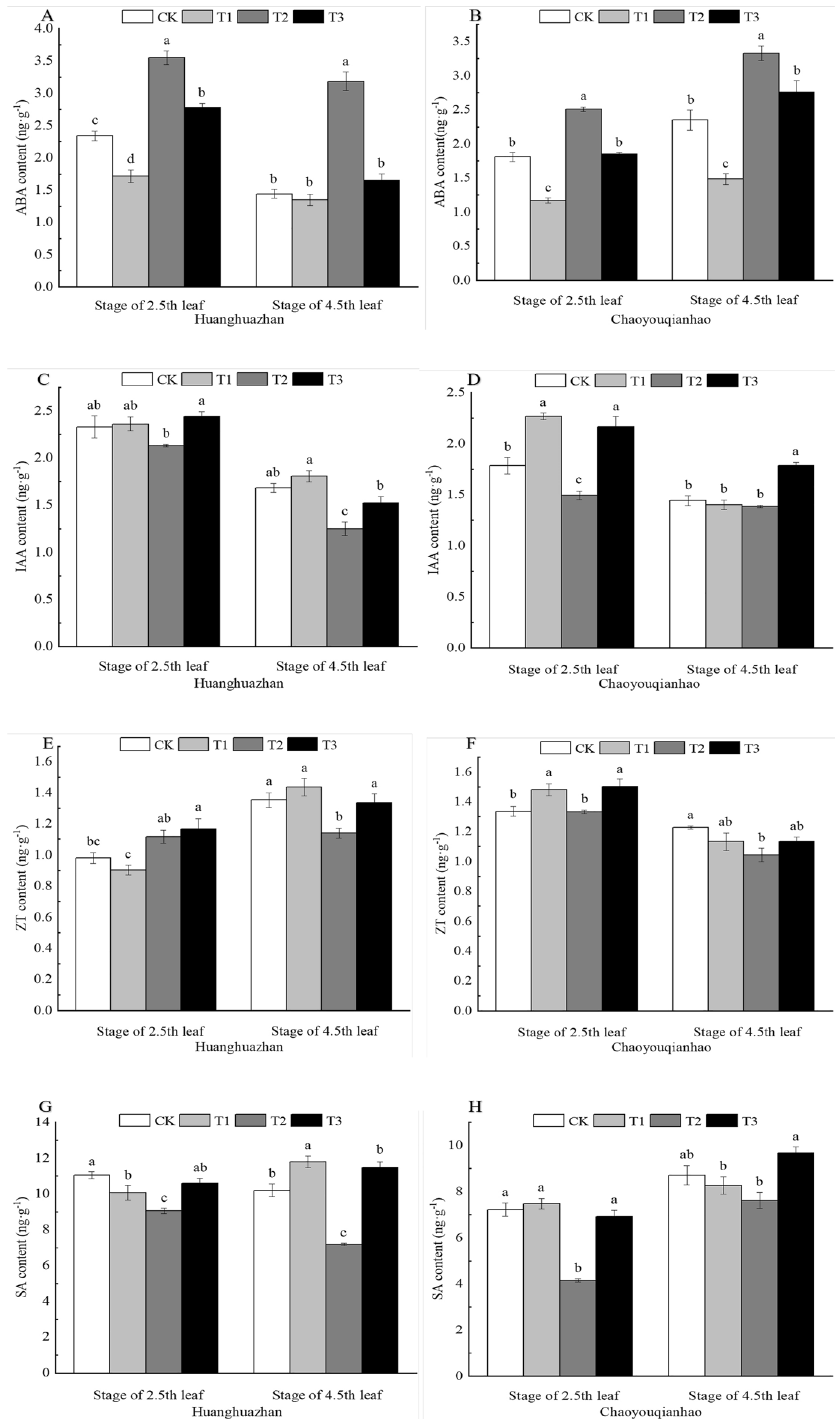
Figure 10. Effects of soaking with BR on hormone content of rice seedlings under salt stress. Different lowercase letters indicate significant differences at the P < 0.05 level. CK: soaking with distilled water + watering 0 g L −1 NaCl. T1: soaking with BR + watering 0 g L −1 NaCl. T2: soaking with distilled water + watering 3 g L −1 NaCl. T3: soaking with BR + watering 3 g L −1